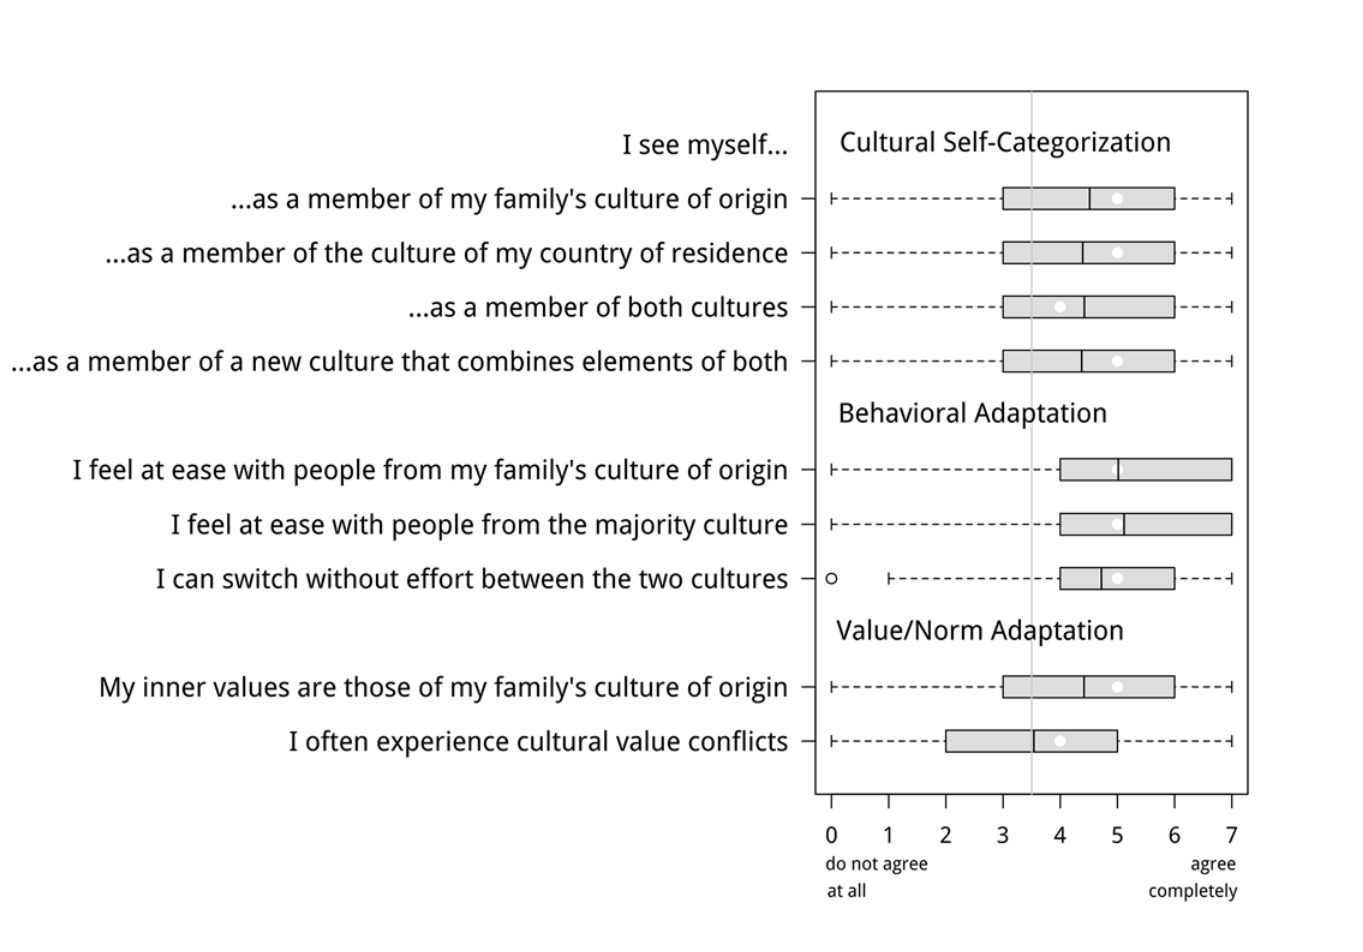
Fig 4. Self-ascribed cultural identity, adaptation on the behavioral level, and on the level of values and norms. Shown are boxplots of the distributions of the corresponding items. The median is represented by a white circle and the mean by a black bar; the box ranges from the first to the third quartile.